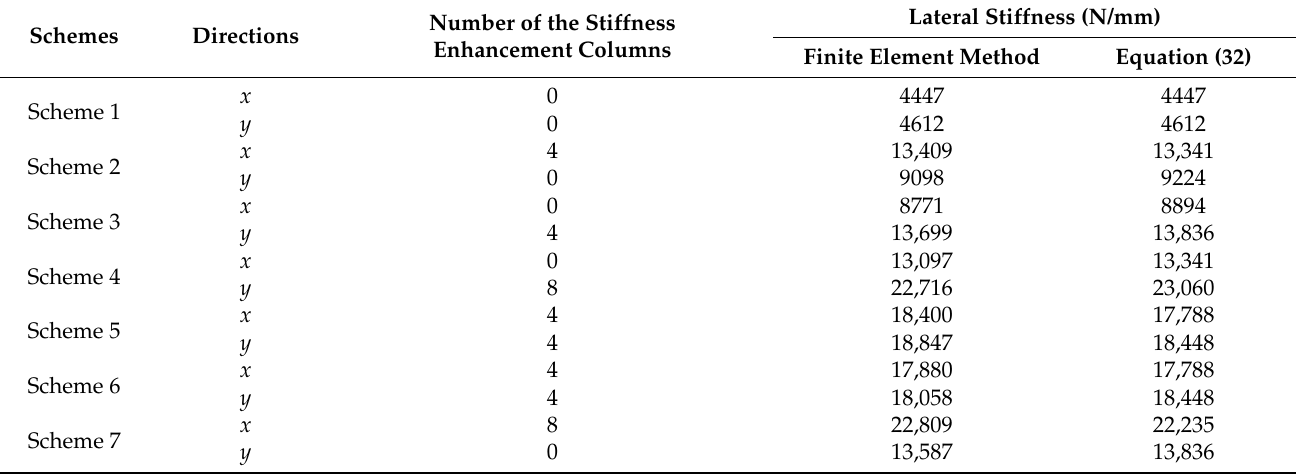
Table 1. Comparison between lateral stiffness of the story calculated by finite element analysis and Equation (32).